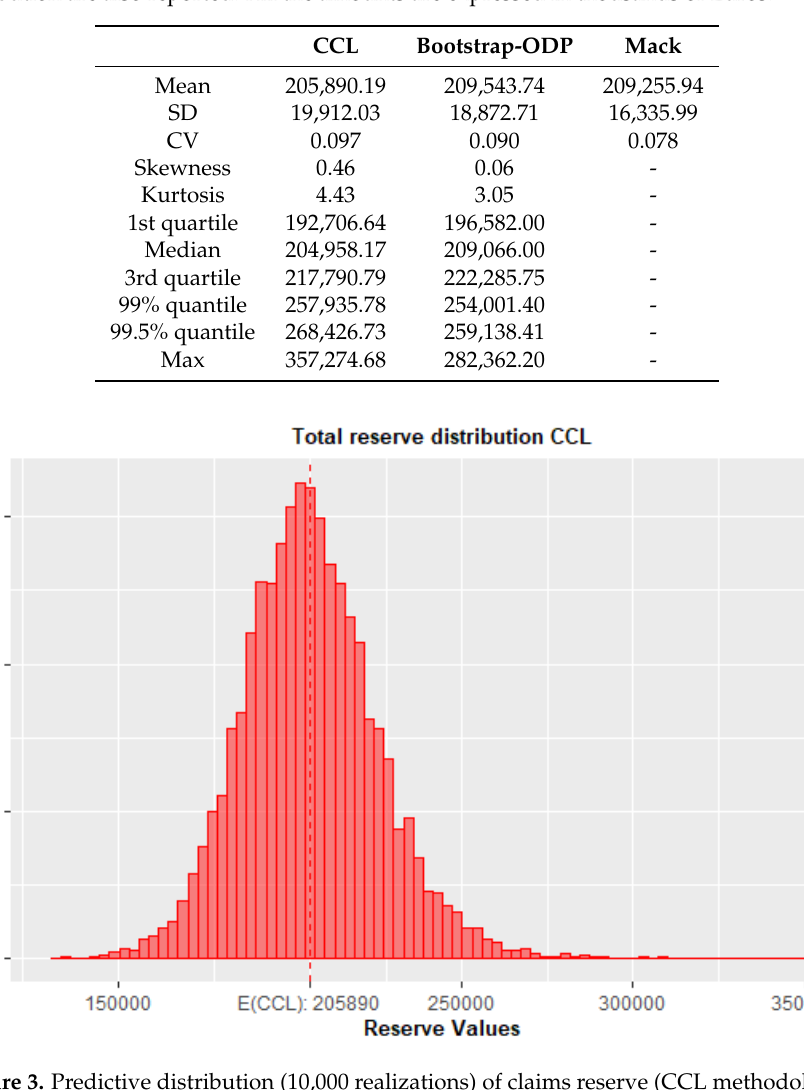
Table 5. Mean, standard deviation (SD), and CV of claims reserve obtained by CCL, Boostrap-ODP, and Mack formula, respectively. For CCL and Boostrap-ODP methods, skewness, kurtosis, and quantiles of the distribution are also reported. All the amounts are expressed in thousands of Euros.